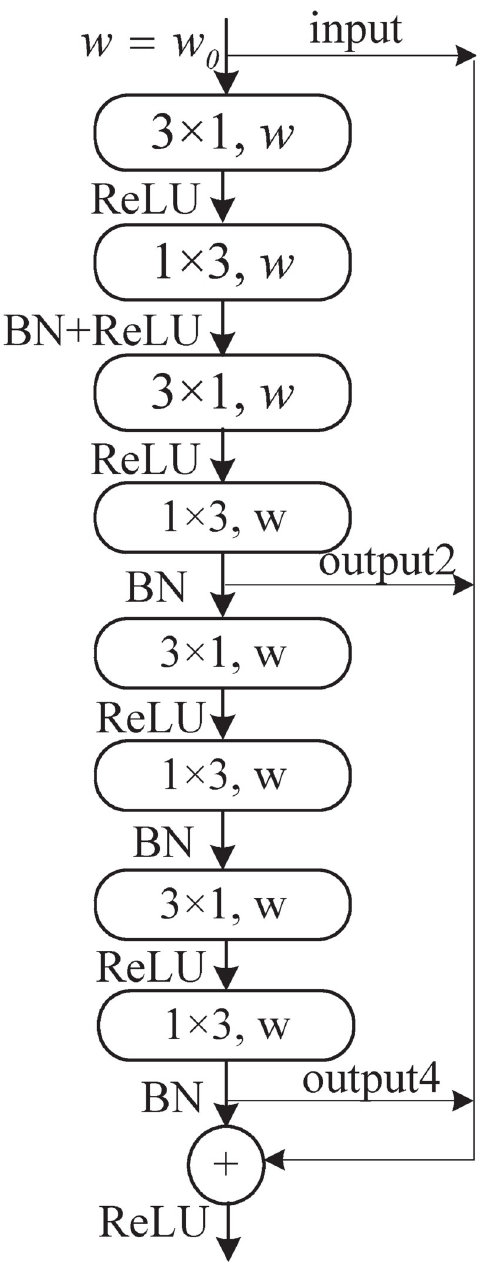
Fig 2. Non-bt-1D-SRC module, where w 0 is the number of output channels in the last layer; here, w 0 is 128. Input, output2, and output4 denote the input features together with the output features after two pairs of 3 × 1 and 1 × 3 combination